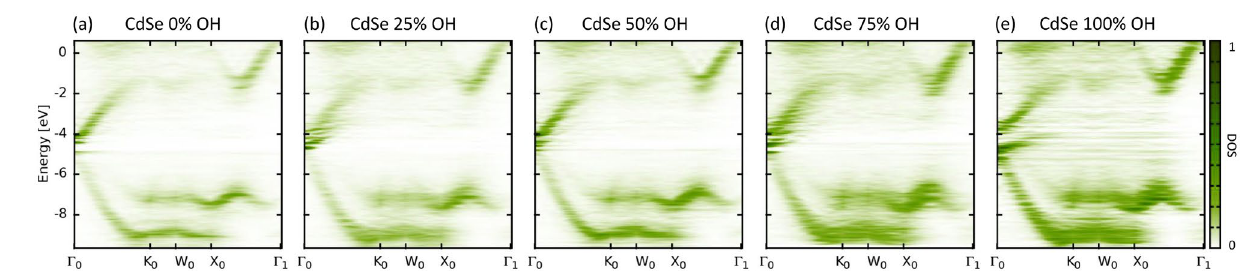
Figure 4. Quasi-band structures of CdSe NCs with ( a ) 0% OH coverage, ( b ) 25% OH coverage, ( c ) 50% OH coverage, ( d ) 75% OH coverage, and ( e ) 100% OH